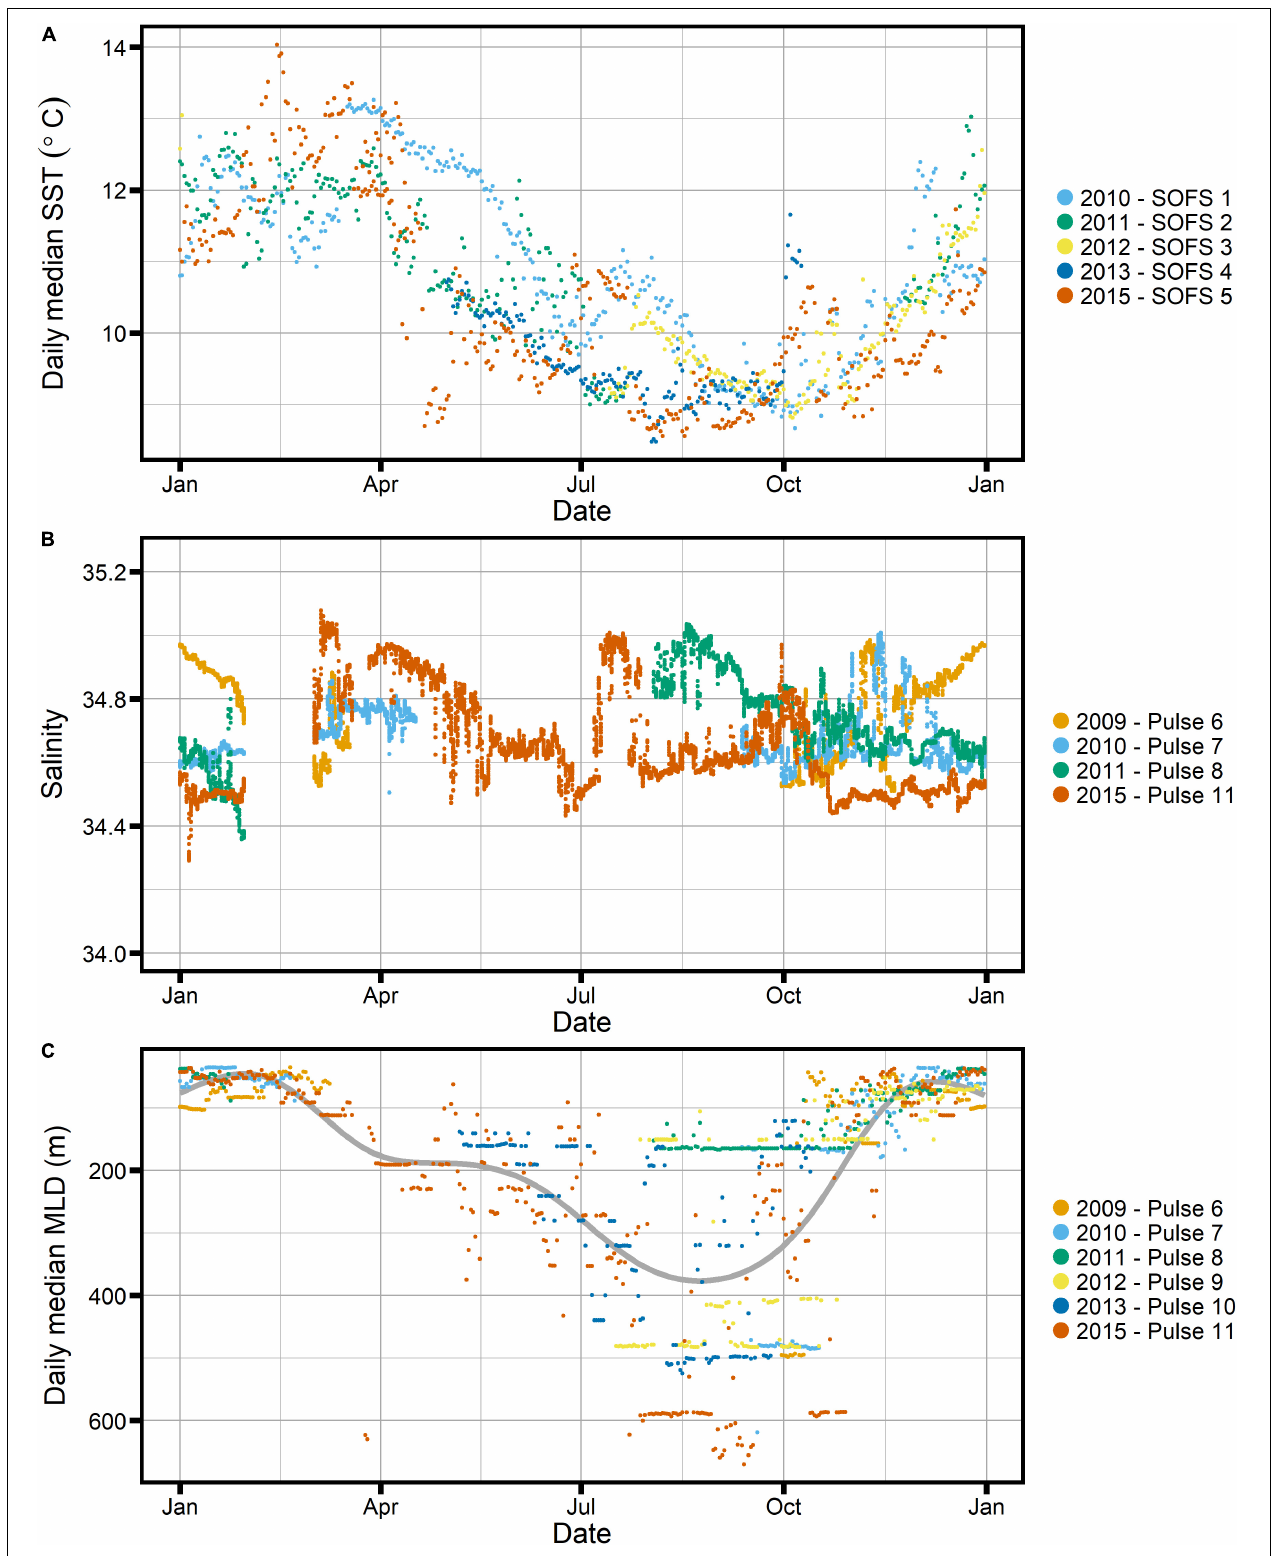
FIGURE 8 | Available mooring data from the SOTS site for (A) daily median sea surface temperature, (B) salinity and (C) daily median mixed layer depth (MLD), estimated based on a temperature threshold of 0.3 ◦ C. Gray line indicates a very smoothed GAM for the data to indicate an “average” annual cycle.